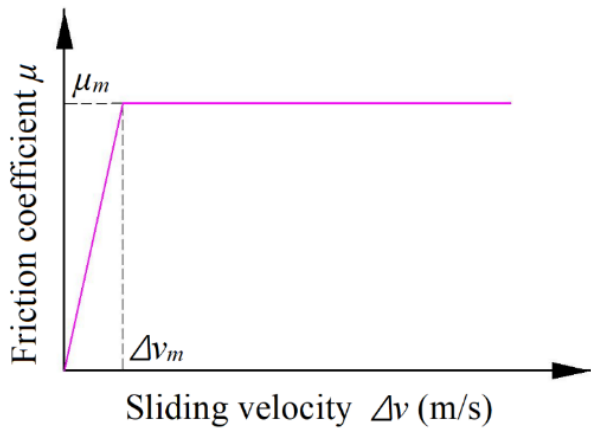
Figure 2. Kinematical relationship for a ball bearing.